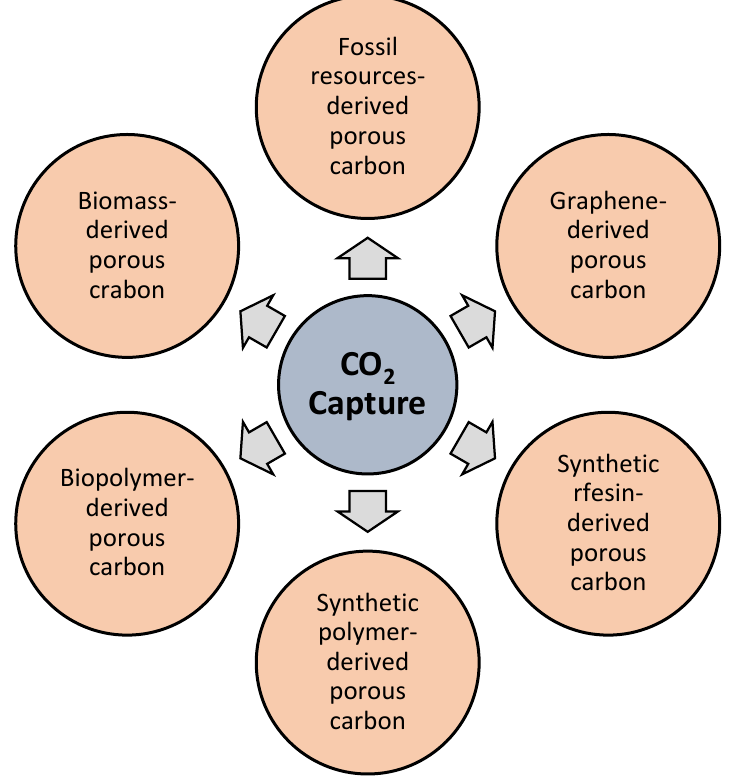
Figure 4. Various precursor-derived porous carbon materials for CO 2 adsorption.